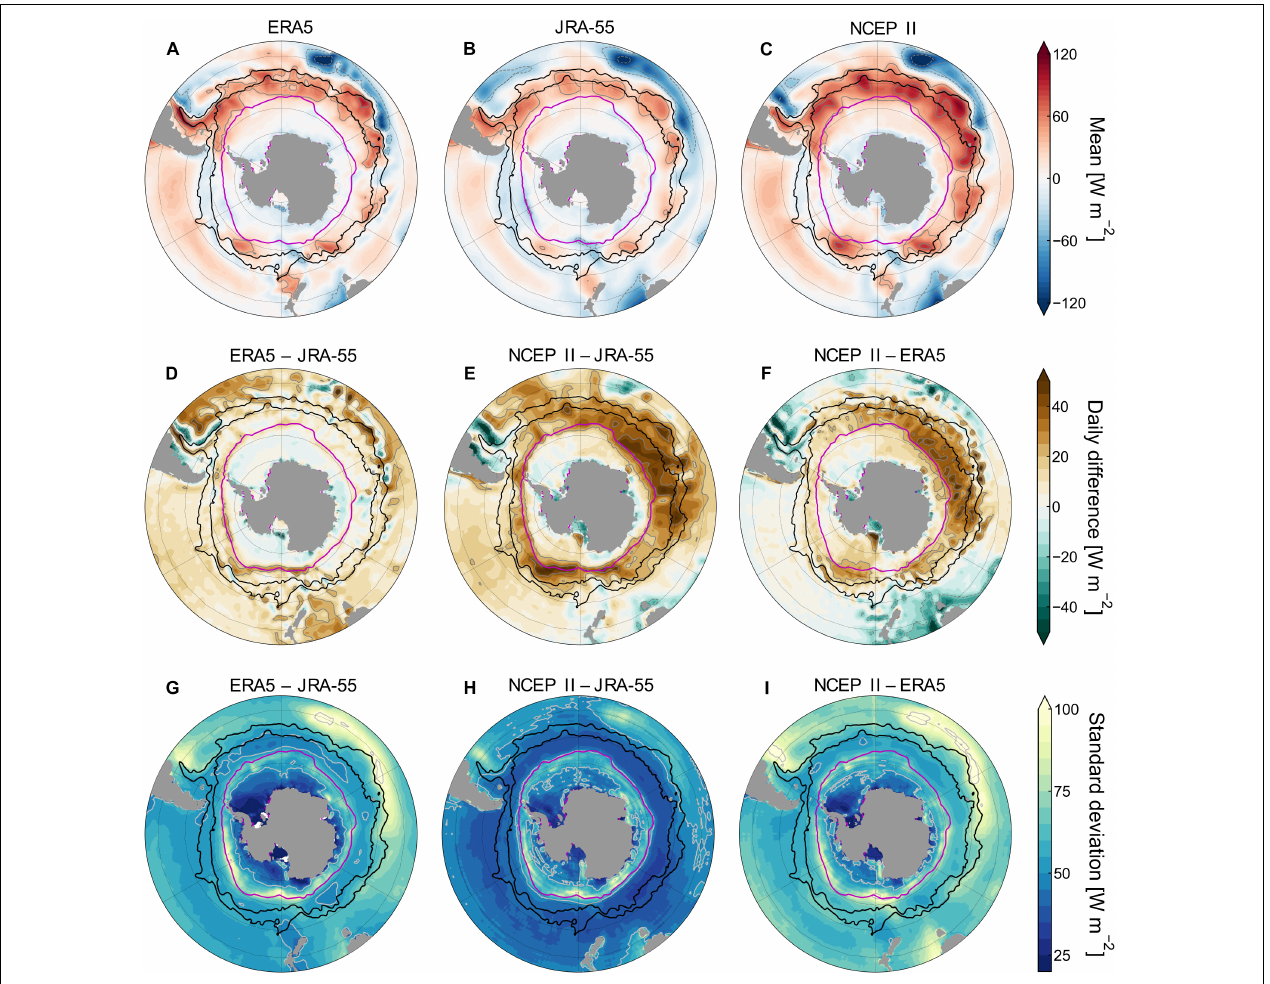
FIGURE 2 | (A–C) The 10-year (2008–2017) mean net heat flux (W m − 2 ) for three reanalysis products: ERA5, JRA-55 and NCEP-II. (D–F) The 10-year mean difference in daily net heat flux (in W m − 2 ) between the products. (G–I) Standard deviation of the daily differences (in W m − 2 ) shown in panel (D–F) . Positive (negative) values denote a heat flux into (out of) the ocean. Magenta line denotes the 10-year mean of the 15% sea ice concentration from NCEP/DOE AMIP-II Reanalysis representing the maximum sea-ice edge. Gray lines contour the mean (–120 to 120 W m − 2 intervals of 40 W m − 2 ), the daily difference (–40 to 40 W m − 2 intervals of 20 W m − 2 ), and standard deviation (50 and 100 W m − 2 ). Solid (dashed) contours represent positive (negative) values. Black contours indicate the 10-year mean position of the Sub-Antarctic Front (north) and Antarctic Polar Front (south) from the AVISO Absolute Dynamic Topography (as in Swart et al.,